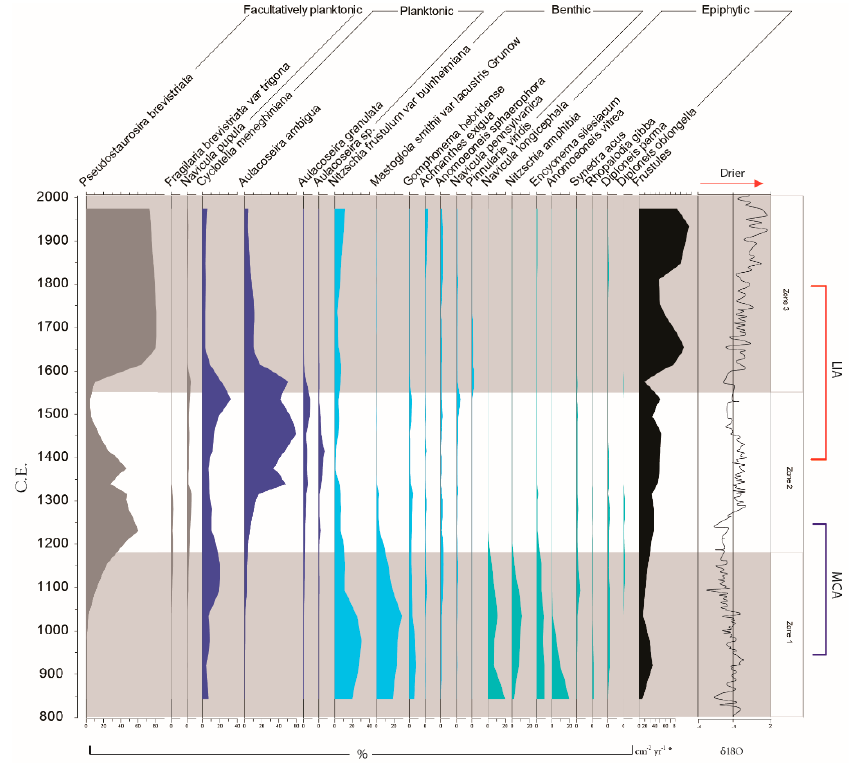
Figure 4. Diatom assemblage reconstructed from El Gancho with δ 18 O data from Stansell et al. [16].